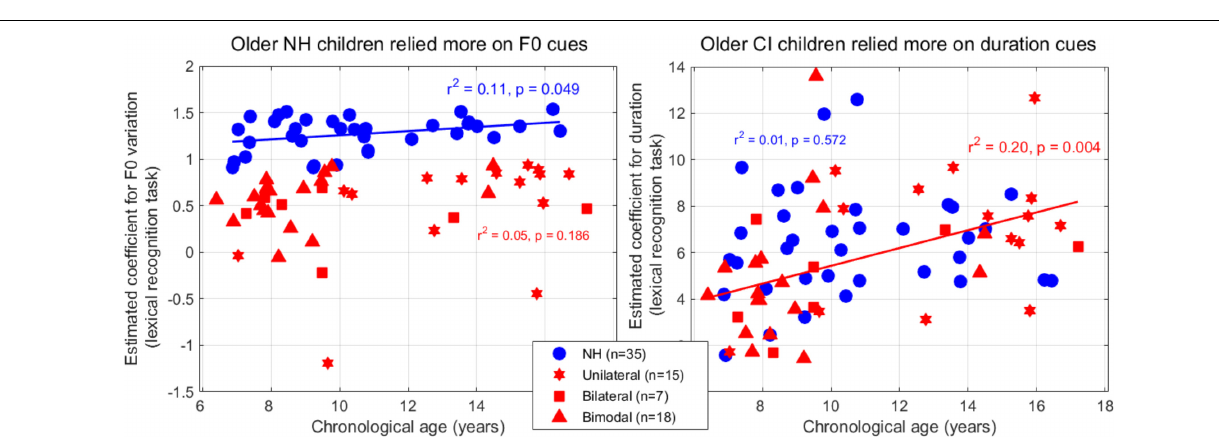
Frontiers in Neuroscience |